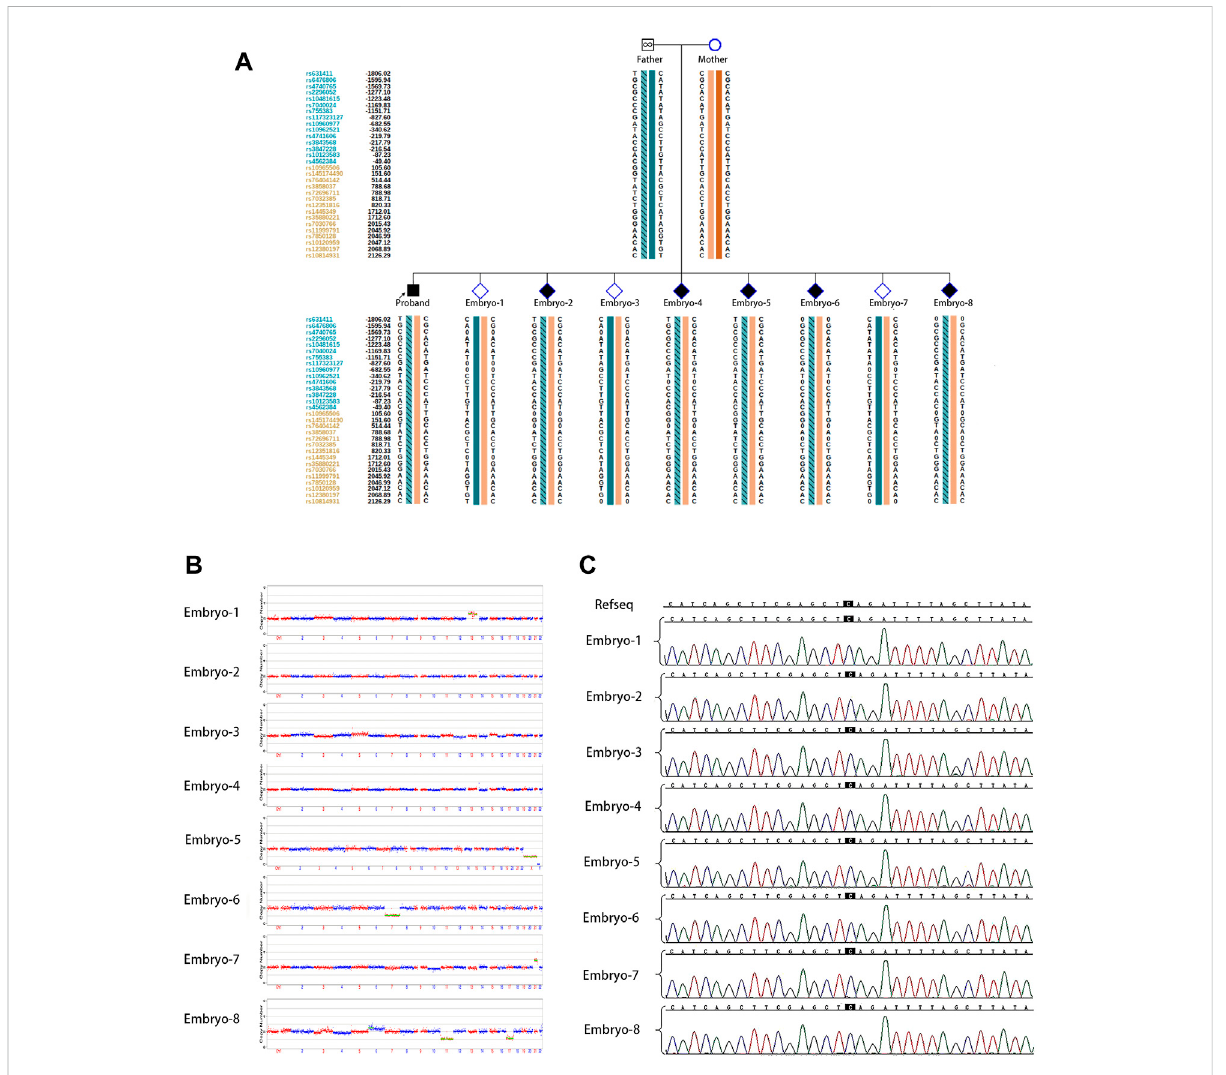
FIGURE 2 PGT for the SMARCA2 variant. (A) Results of haplotype linkage analysis in SMARCA2 gene in parents. PGT haplotype analysis in embryos 1 to 8. Orange band means chromosome from mother, cyan band without slashes means normal chromosome from father, and cyan band with slashes means chromosome from father. Embryos 1, 3, and 7 showed the absence of disease-causing variants.; (B) PGS revealed that embryos 2, 3, and 4 were euploidy; (C) Sanger sequencing of DNA from all eight embryos showed the absence of SMARCA2 variants at c